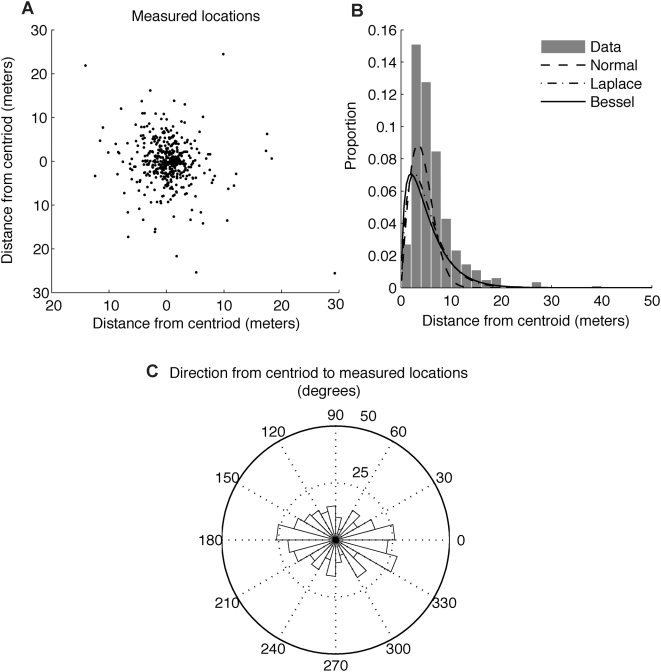
Estimating the distribution of measurement error from the stationary collar experiment.(A) GPS data collected from the stationary Lotek 2200 GPS collar. Only locations with PDOP<6 were retained (n = 406). (B) The distance from each measured location to the centroid was used to determine the best-fit distribution of GPS measurement error. Data is shown as the grey bars (in two meter intervals), the Bessel distribution (ρ = 0.303) is shown as the solid line, the Laplace (β = 2.59) is the dash-dot line, and the Normal distribution (σ = 4.80) is the dashed line. (C) Frequency of directions from the centroid to the measured location. There is no consistent bias in the direction of location errors (Table 2).